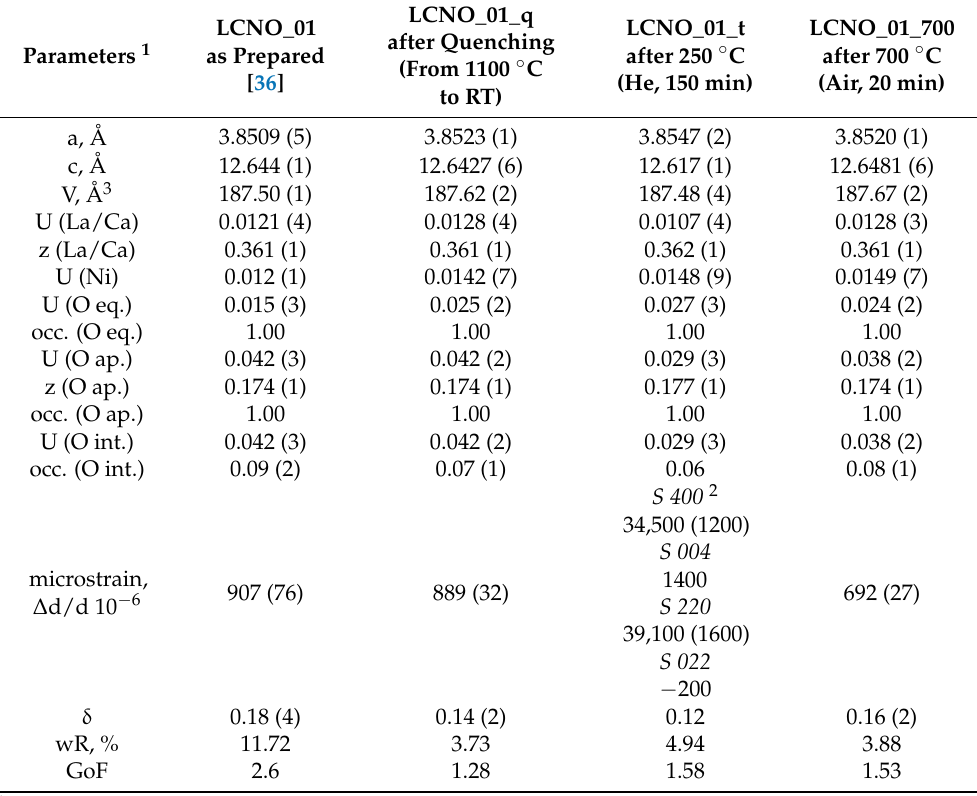
Table 1. Results of Rietveld refinement of LCNO_01 structure at